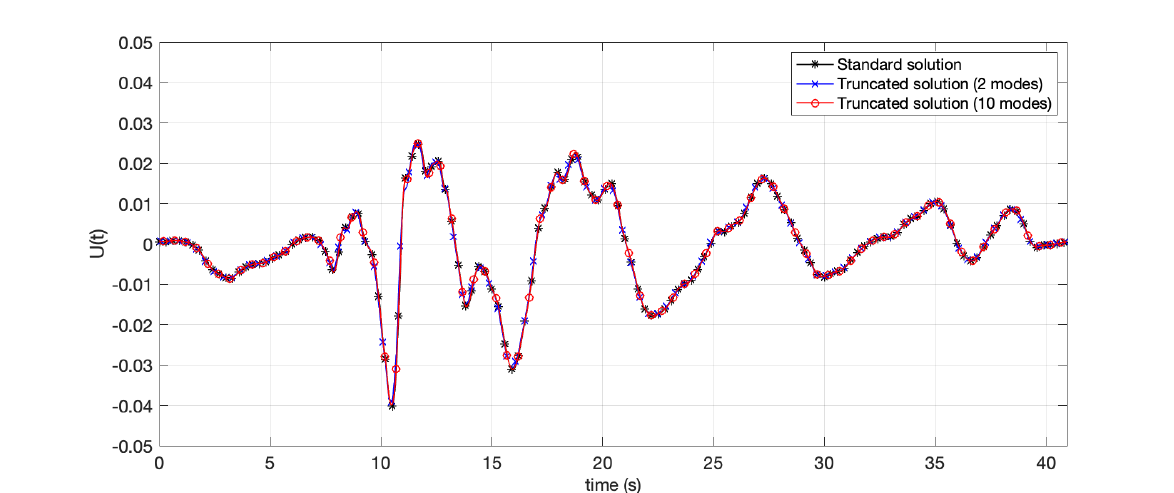
Figure 2. Time evolution of the displacement at the surface using the truncated Extended Harmonic-Modal Hybrid (XHMH)